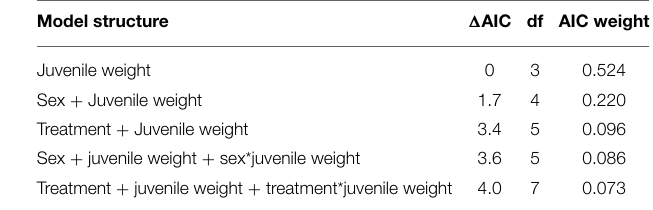
TABLE 4 | Top five models predicting the latency to become active. Model structure